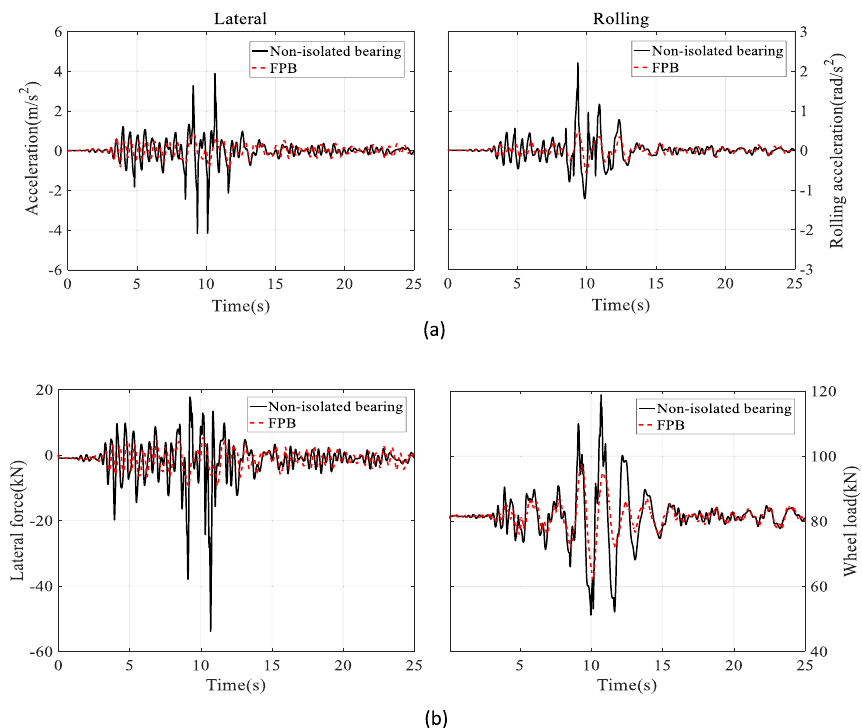
Fig. 23 Responses of the vehicle undergoing No.1 ground motion: a car-body; and b wheel-rail